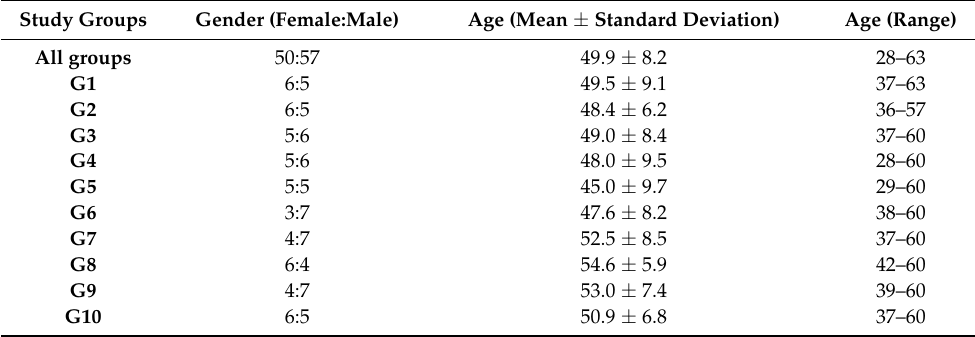
Table 1. Patient demographics for all study groups and per study